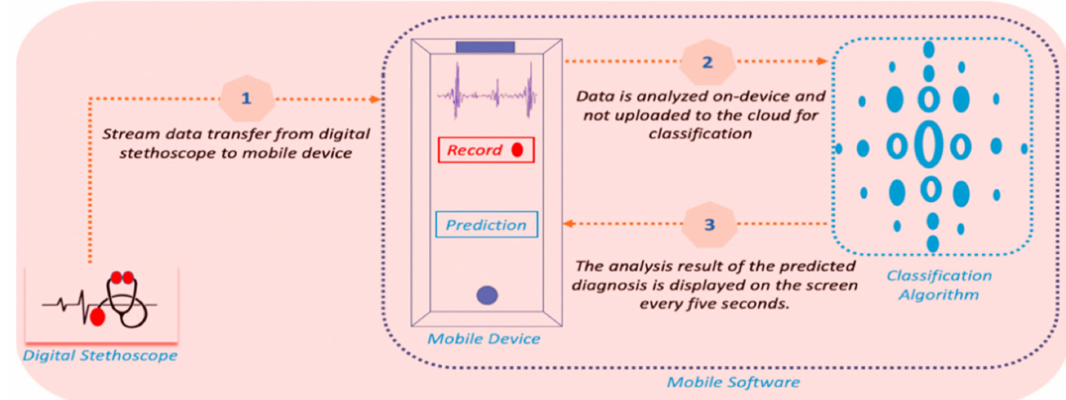
Figure 2. Workflow of the software. First, data is transferred from digital stethoscope to mobile device, then, the classification algorithm predicts the diagnosis, and the result is displayed simultaneously on the screen.